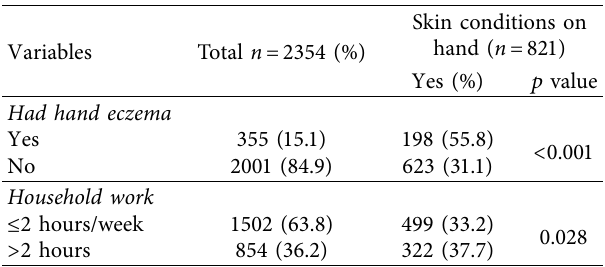
Table 2: Factors leading to skin conditions on hands during